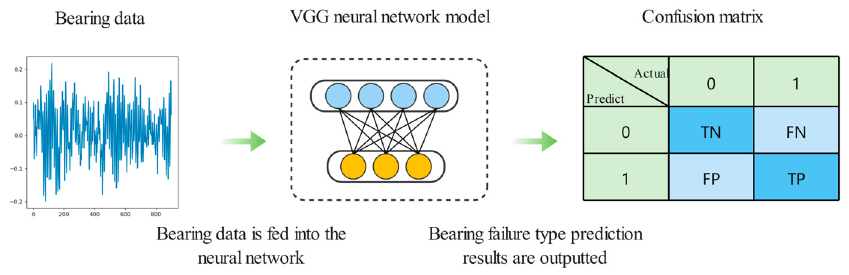
Figure 10. The generation process of the confusion matrix.